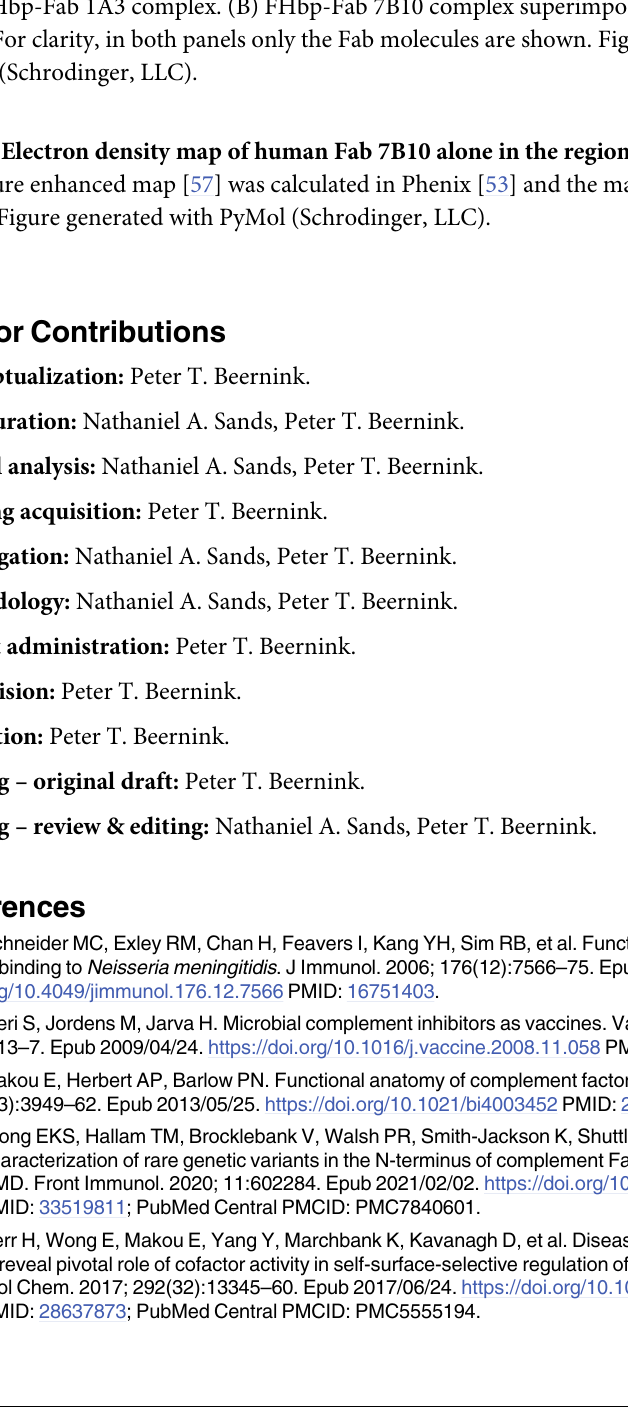
S5 Fig. Atomic interactions between Fab 7B10 and FHbp. The color scheme is the same as in S4 Fig. The Figure was generated using the Antibody feature in LigPlot+ and CDR loops were defined by Kabat convention implemented in LigPlot+ [56]. S6 Fig. Structural comparisons of human Fabs. (A) FHbp-Fab 7B10 complex superimposed with FHbp-Fab 1A3 complex. (B) FHbp-Fab 7B10 complex superimposed with Fab 7B10 alone. For clarity, in both panels only the Fab molecules are shown. Figure generated with PyMol (Schrodinger, LLC). S7 Fig. Electron density map of human Fab 7B10 alone in the region of CDR-H3. The 2Fo- Fc feature enhanced map [57] was calculated in Phenix [53] and the map is contoured at 1.2 sigma. Figure generated with PyMol (Schrodinger,